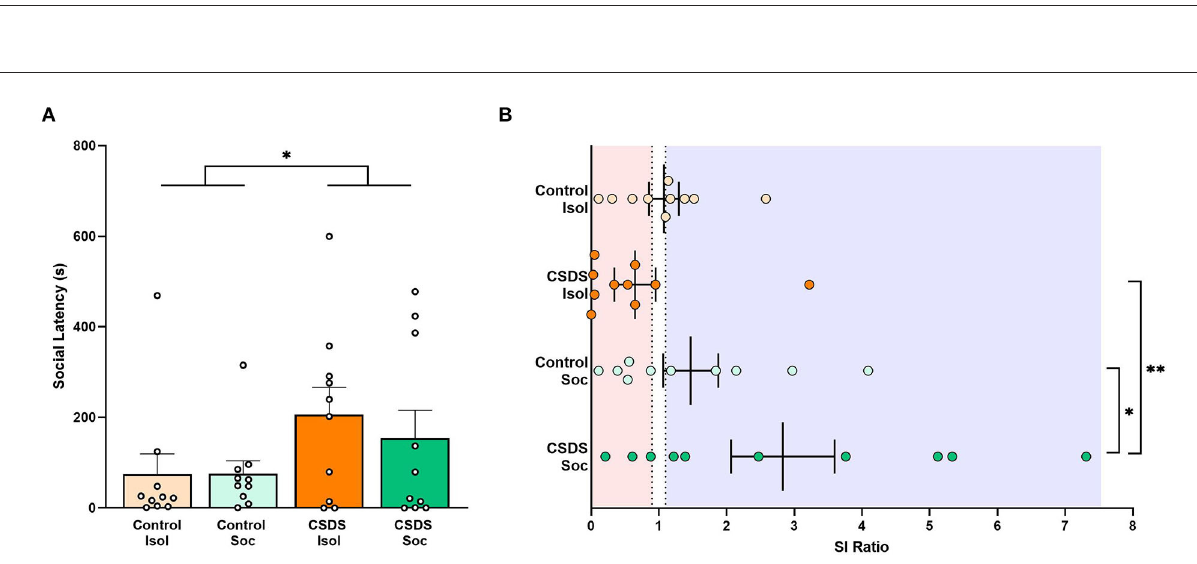
FIGURE4 Effects of social isolation and CSDS on social approach. (A) Latency (s) to approach the stimulus. Data are presented as mean ± SEM and dots represent individual data. (B) Social interaction (SI) ratios were calculated for all subjects ( = the time spent in social zone with the stimulus present divided by the time spent in the social zone with the stimulus absent). Dotted lines indicate SI ratios at 0.9 and 1.1, with red transparent panel indicating a socially avoidant phenotype (SI ratios < 0.9) and blue transparent panel indicating a prosocial phenotype (SI ratios > 1.1). Color scheme follows Figure 1 where orange = isolated; green = group-housed; dark colors = chronic social defeat; light colors = control (no chronic social defeat). Data presented as mean ± SEM and dots represent individual data. * p < 0.05; ** p <